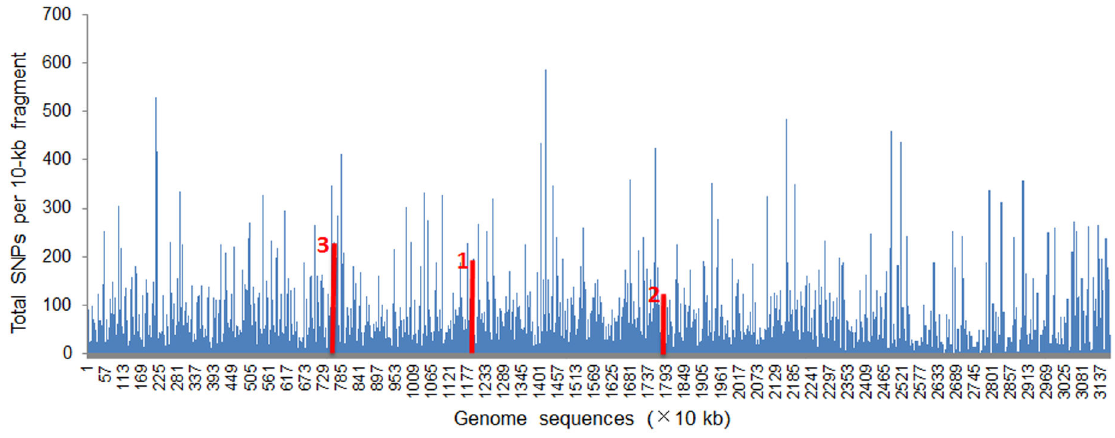
Figure 2. SNP sites comparison between the genome sequences of two U. virens isolates. The SNP numbers per 10 kb DNA were compared using two genomes sequences and Biolign software version 4.0.6 (Hall 2001). Locations of the three SNP-rich markers are indicated by red